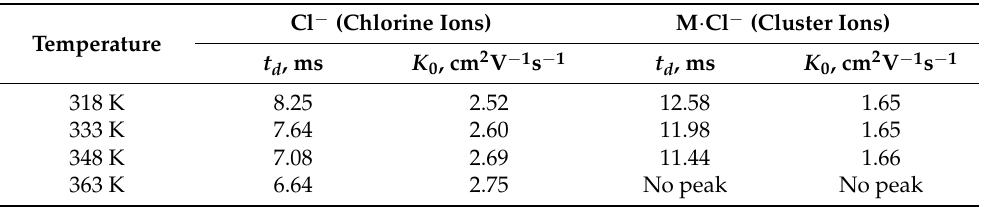
Table 1. Drift times and reduced mobilities of ions observed in the drift time spectra measured in the system shown in Figure